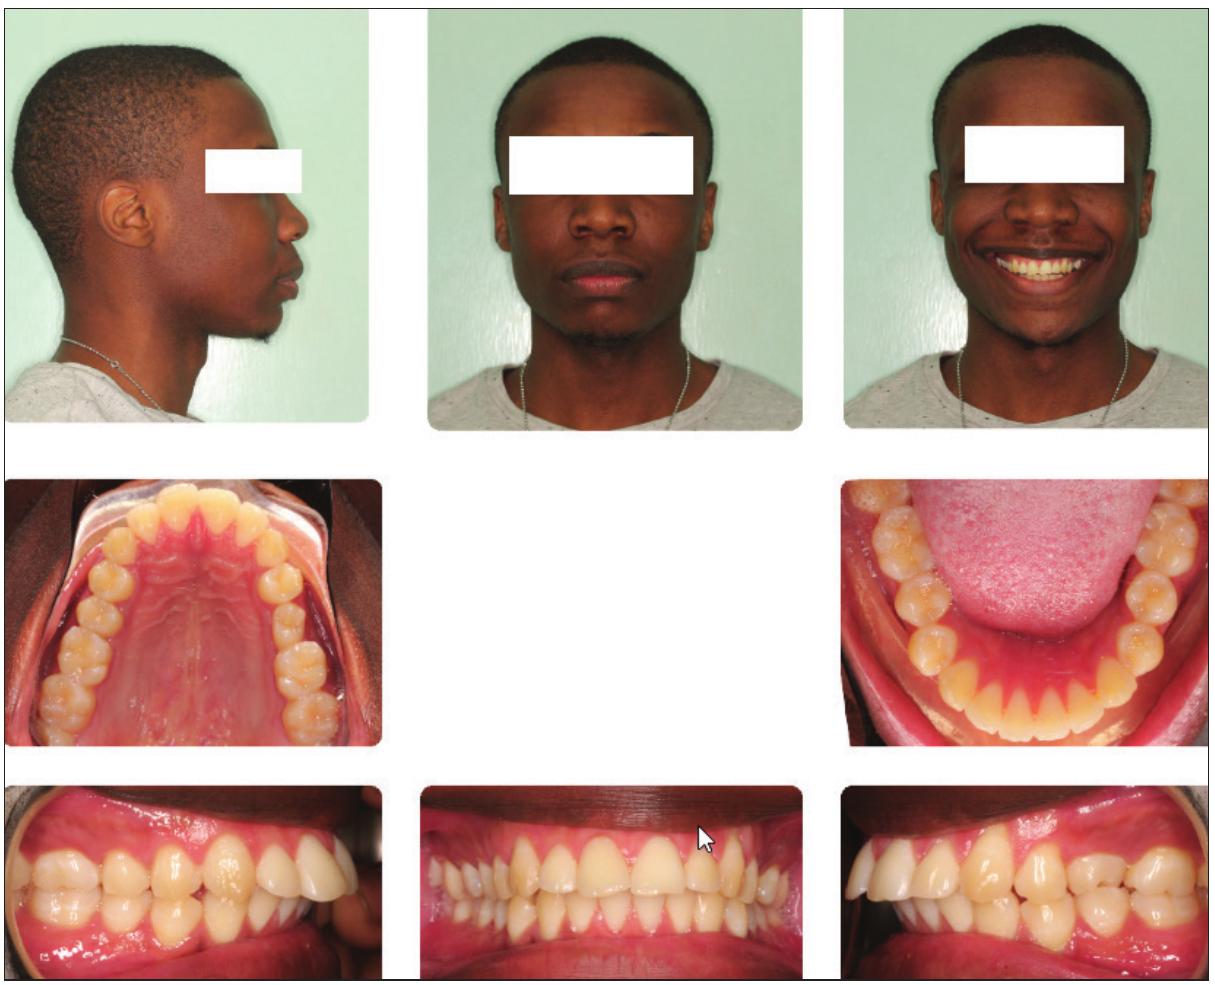
Figure 11. Case example at treatment start. Teeth 15, 25 to be